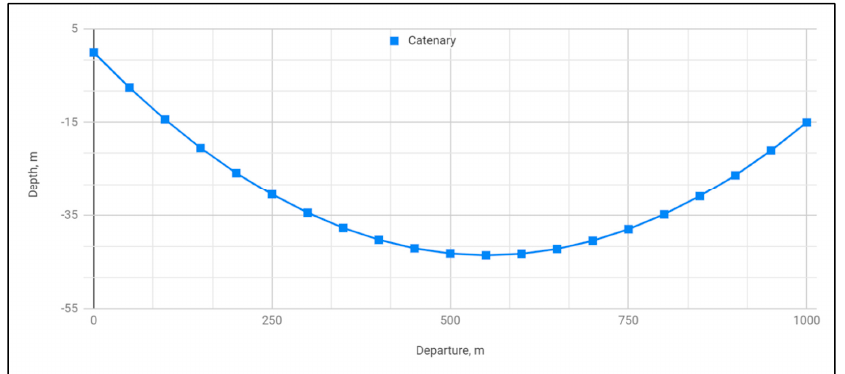
Figure 8. Catenary trajectory.